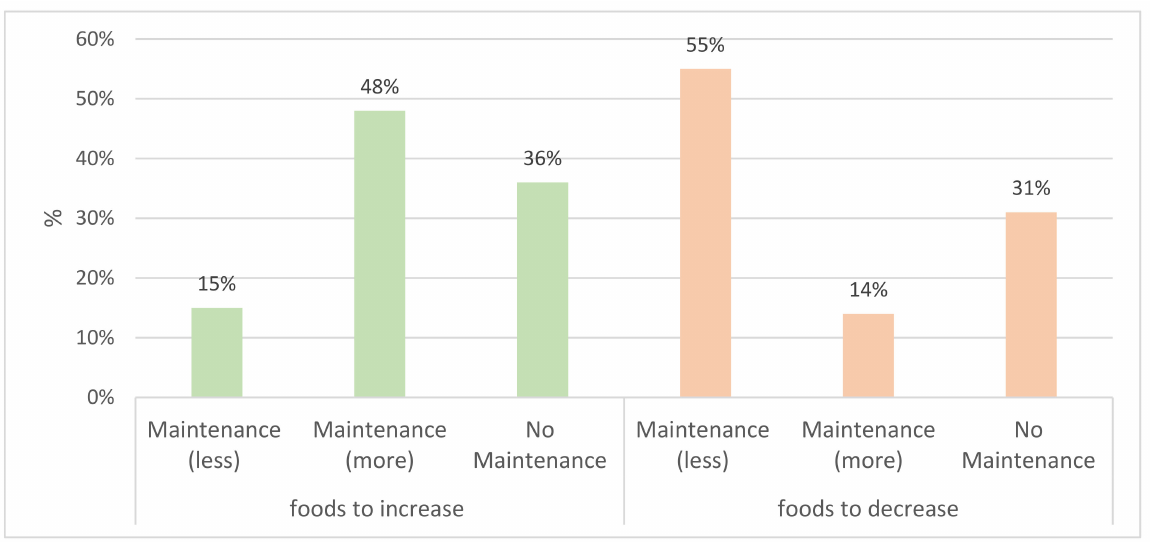
Figure 3. Maintenance of changes in consumption per food category after lockdown. N = 646 for foods to decrease; N = 568 for foods to